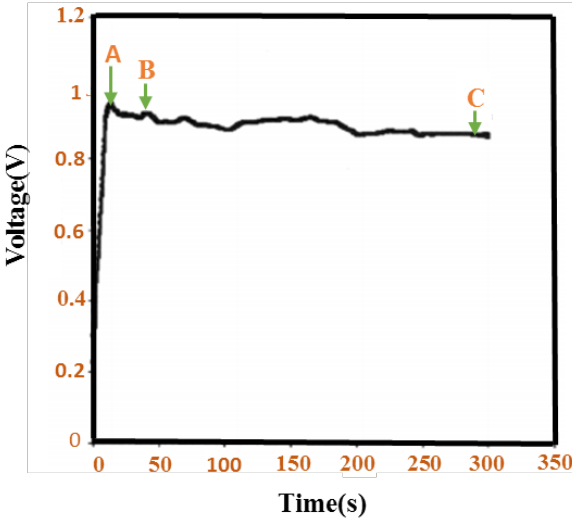
Figure 17. PANI film with galvanostatic deposition. Reproduced from Eur. Polym. J., 125, Kumari Jangid, N.; Jadoun, S.; Kaur, N., A review on high-throughput synthesis, deposition of thin films and properties of polyaniline, Copyright (2020), with permission from Elsevier.